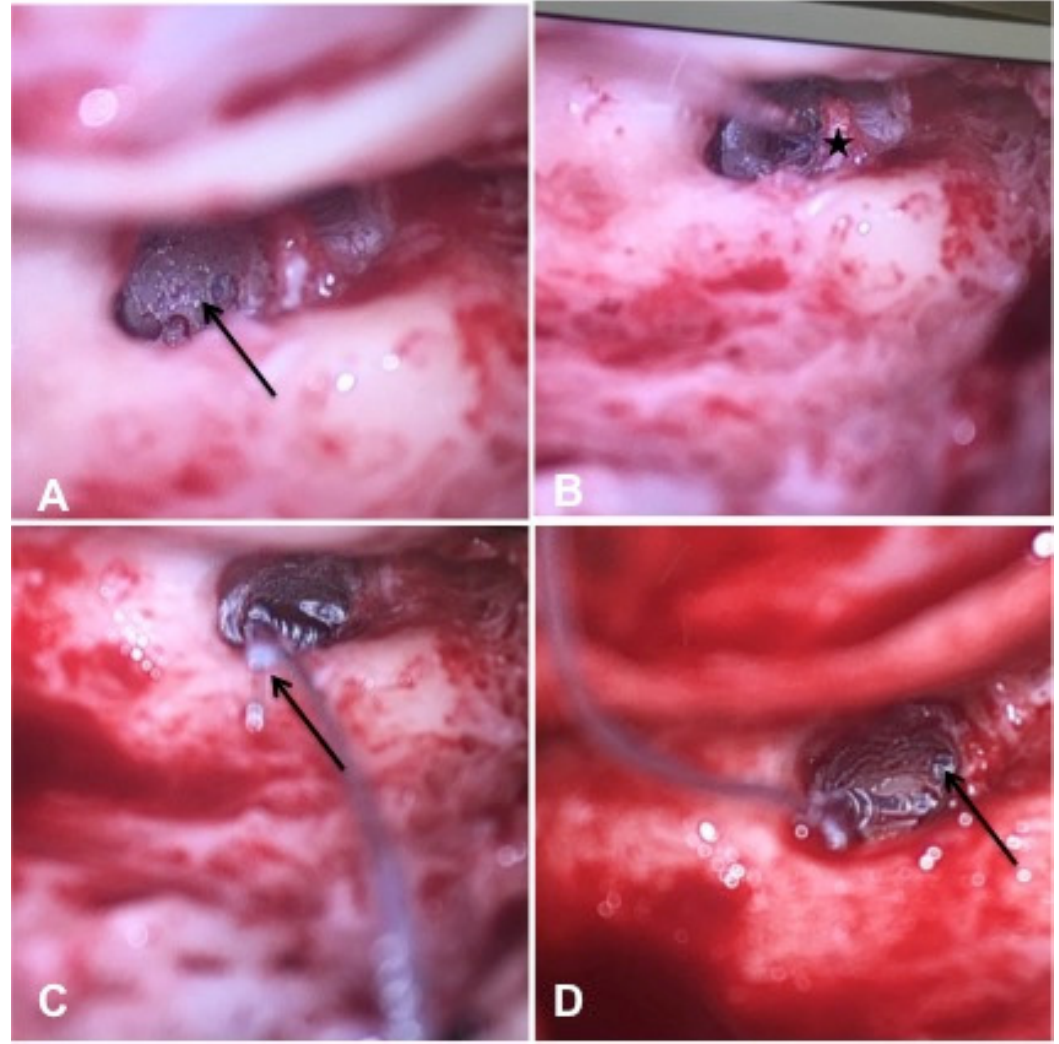
Figure 6. Case # 9: Intraoperative images demonstrating ILS-tumor resection surgery from the basal turn of the cochlea and cochlear implantation. ( A ) ILS in the basal turn after removing the promontory wall and bony structures around the round window (black arrow). ( B ) Resection of the ILS (asterisk marks the cochlear modiolus). ( C ) Insertion of the cochlear implant CI 612 (black arrow marks the stylet of the electrode). ( D ) Image after complete insertion of the electrode. The tip of the electrode can be seen in the middle turn (black arrow).